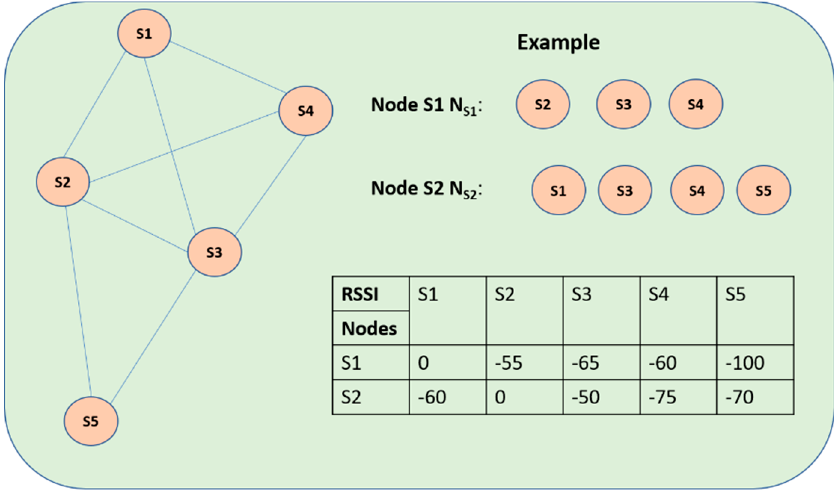
Figure 7 . Nearby nodes distance calculation using Manhattan method. Figure 7. Nearby nodes distance calculation using Manhattan